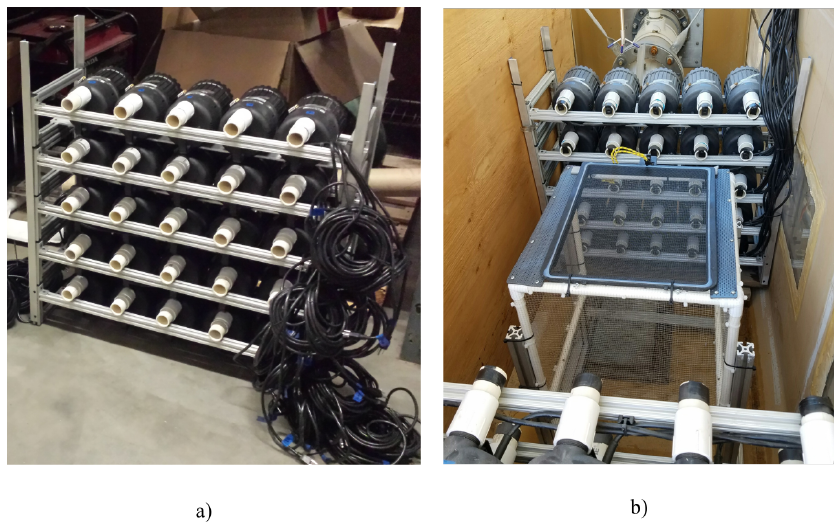
Figure 2. Implementation of RASJA experiments; ( a ) Installation of submersible pumps onto racks during the construction of one RASJA, and ( b ) location of the net pen between the dual RASJA